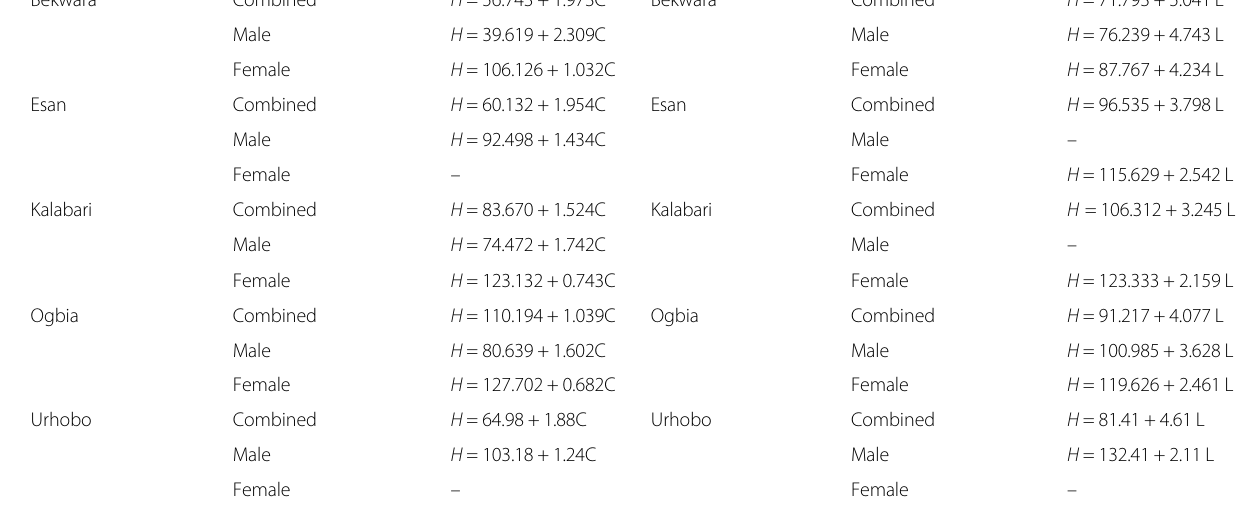
Table 3 Simple regression formulae for height estimation using the head circumference Ethnicity Data